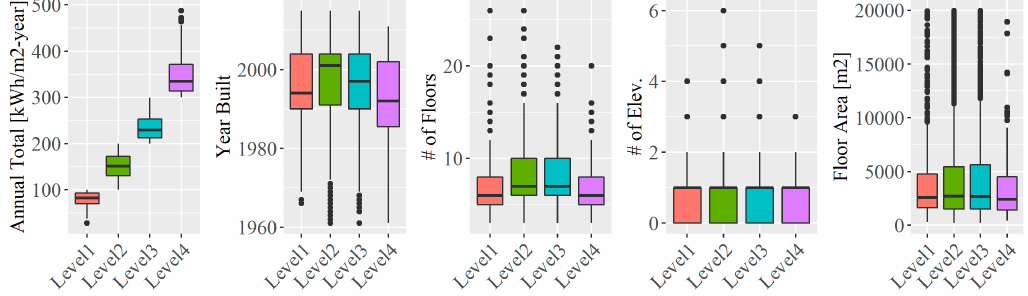
Figure 12. Boxplots of annual total building energy with respect to building characteristics in Seoul, Korea. (The ggplot2 package on R was used). Table 4. Descriptive statistics of the data on annual total building energy with respect to building characteristics in Seoul, Korea.